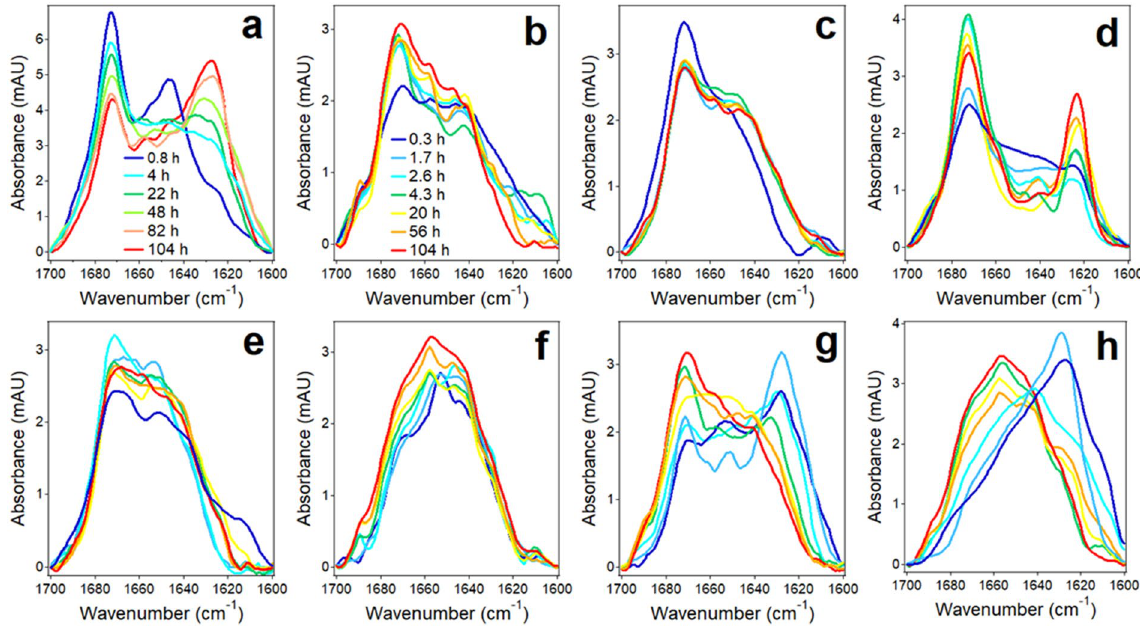
Figure 2. FTIR spectra at indicated times of incubation in D 2 O-based buffer (25 mM NaCl, 25 mM Na,K- phosphate, pD 7.2) for Aβ 1–42 ( a ) and peptides P1 ( b ), P2 ( c ), P3 ( d ), P4 ( e ), P5 ( f ), P6 ( g ), and P7 ( h ) at 25 °C. The concentrations of the peptides were 50 μM for Aβ 1–42 and 100 μM for the fragments. Times of incubation in buffer of all fragments are indicated in panel ( b